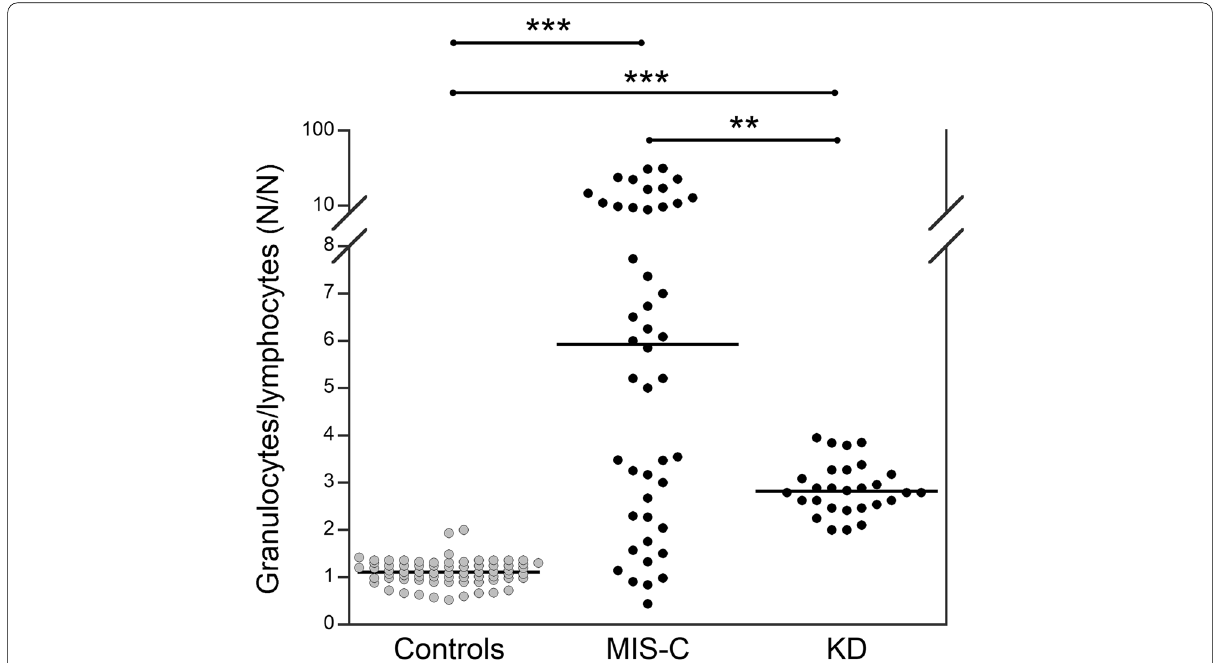
Fig. 1 Comparison of granulocytes/lymphocytes ratio in controls ( n KD: Kawasaki disease; MIS-C: multisystem inflammatory syndrome in